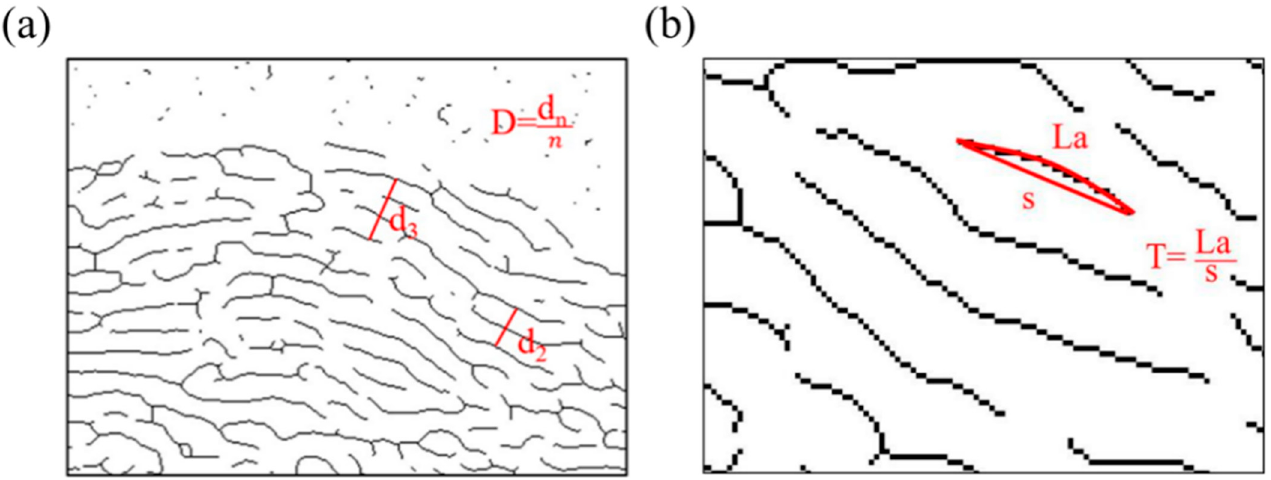
Figure 4. Schematic diagram of carbon layer spacing ( a ) and distortion ( b ).